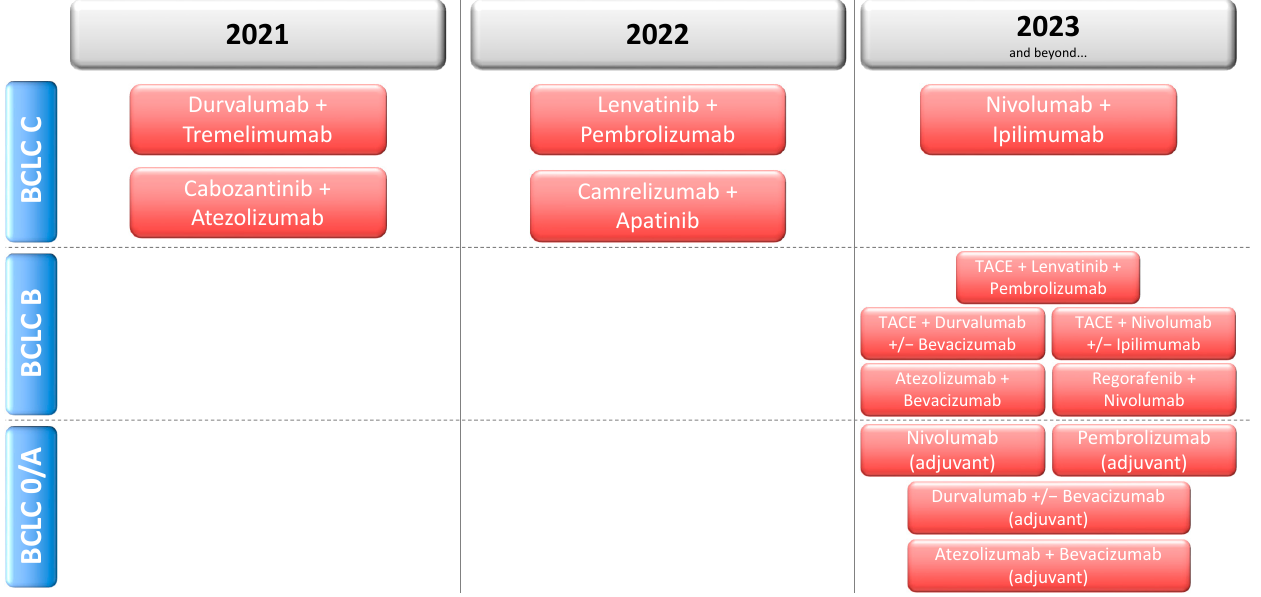
Figure 1. Expected years of availability of results from ongoing phase 3 clinical trials in